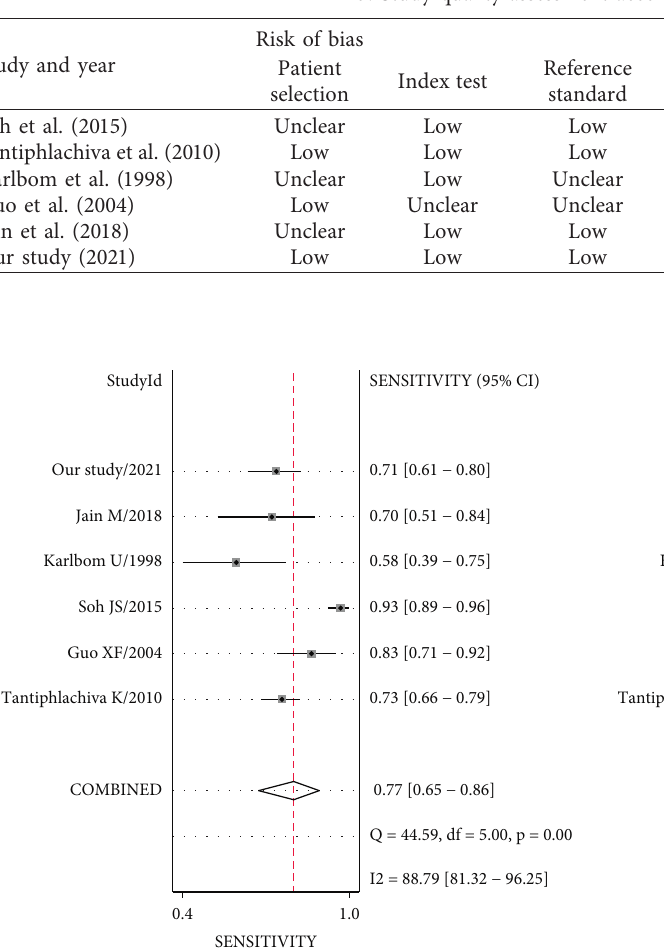
Table 3: Study quality assessment according to QUADAS-2 tool.